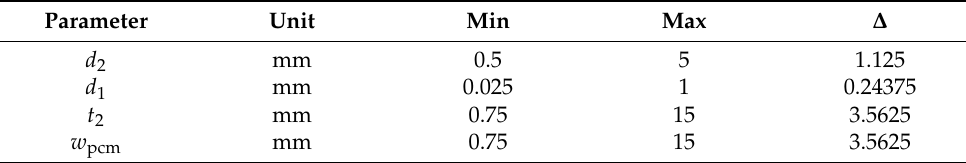
Table 7. Variations of the geometrical parameters.